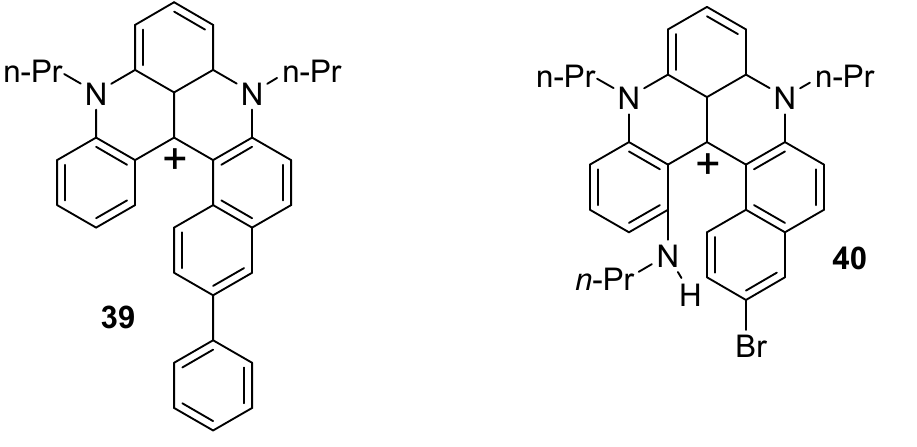
Figure 6. Cationic diazahelicene structures.